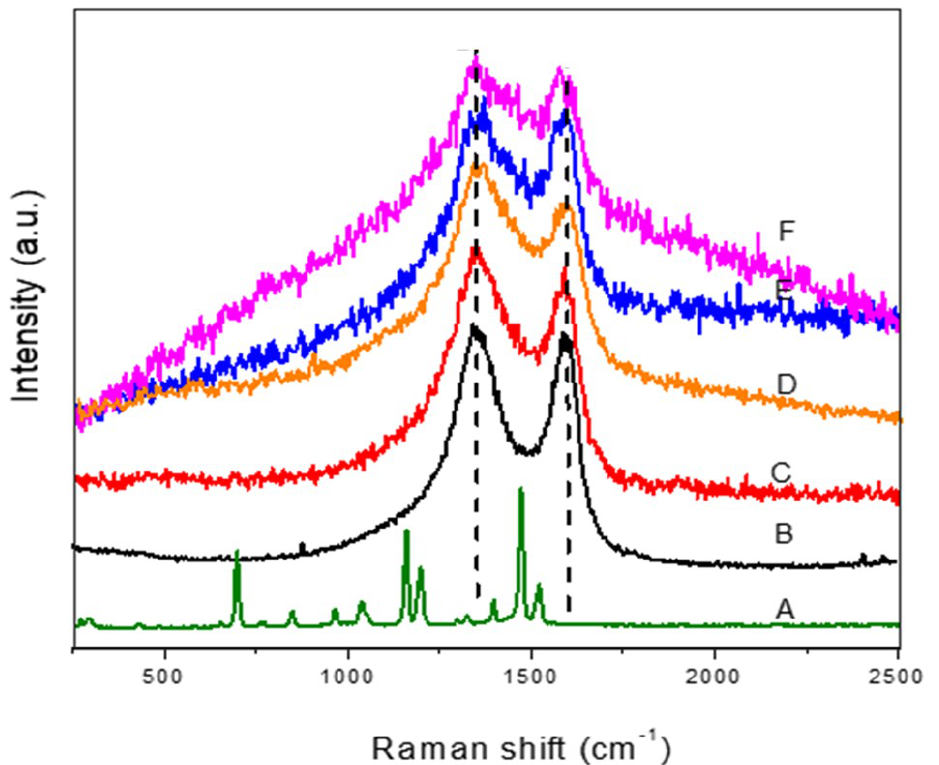
Figure 5. Evolution of the Raman spectra with increasing ZIF-8 content as well as the reference starting materials; ( A ) ZIF-8; ( B ) GO; ( C ) ZIF-8@GO 0.1:1; ( D ) ZIF-8@GO 0.5:1; ( E ) ZIF-8@GO 0.9:1; ( F ) ZIF-8@GO 1.0:1. Table 4. BET measurements and Raman D and G band ratios of the prepared materials.